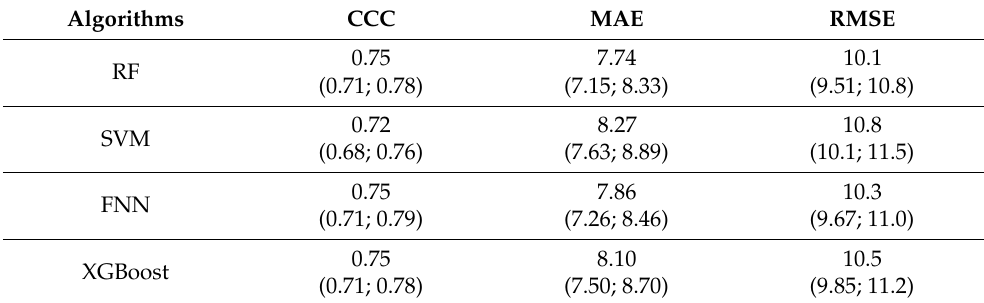
Table 2. Comparison of four different machine-learning algorithms to predict gross motor function using patient data and medical device information: Accuracy to predict the GMFM-66 using the MDS. Algorithms